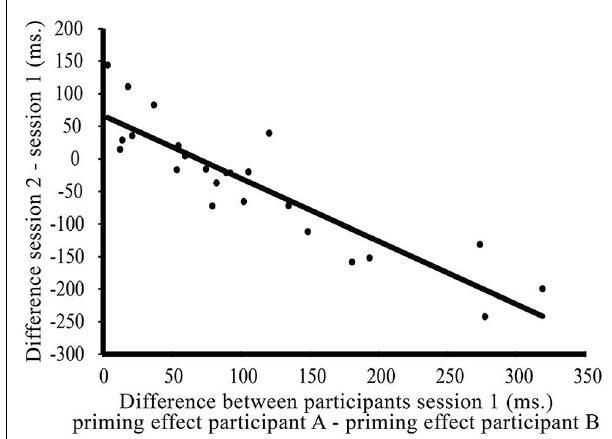
FIGURE 7 | Correlation between the difference between paired participants’ syntactic priming effects in session one of the experiment ( x -axis: priming effect speakerA – speaker B) and the decrease/increase of that difference over time ( y axis: difference part two – difference part one). So, the more different paired individual’s syntactic priming effects are in session one of the experiment, the more this difference will decrease between session one and session